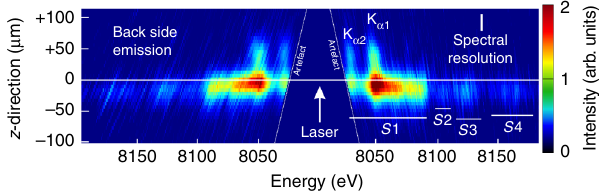
Fig. 2 Experimental spectrum. Mirror-symmetric spectral records show K α -structure (cold K α ; 1 ; 2 as well as heated K α -emission of groups S 1 ; S 2 ; S 3 ; S 4) and its extension along z -axis. The spectral resolution of λ = Δ λ (cid:4) 5200 is visualized by the width of the white vertical bar ( (cid:4) 1 : 5 eV